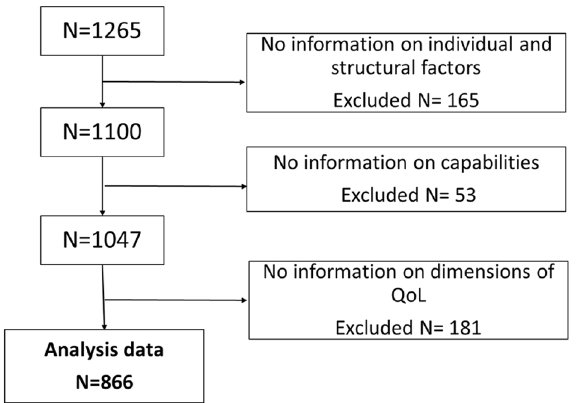
Figure 2. Reduction of the